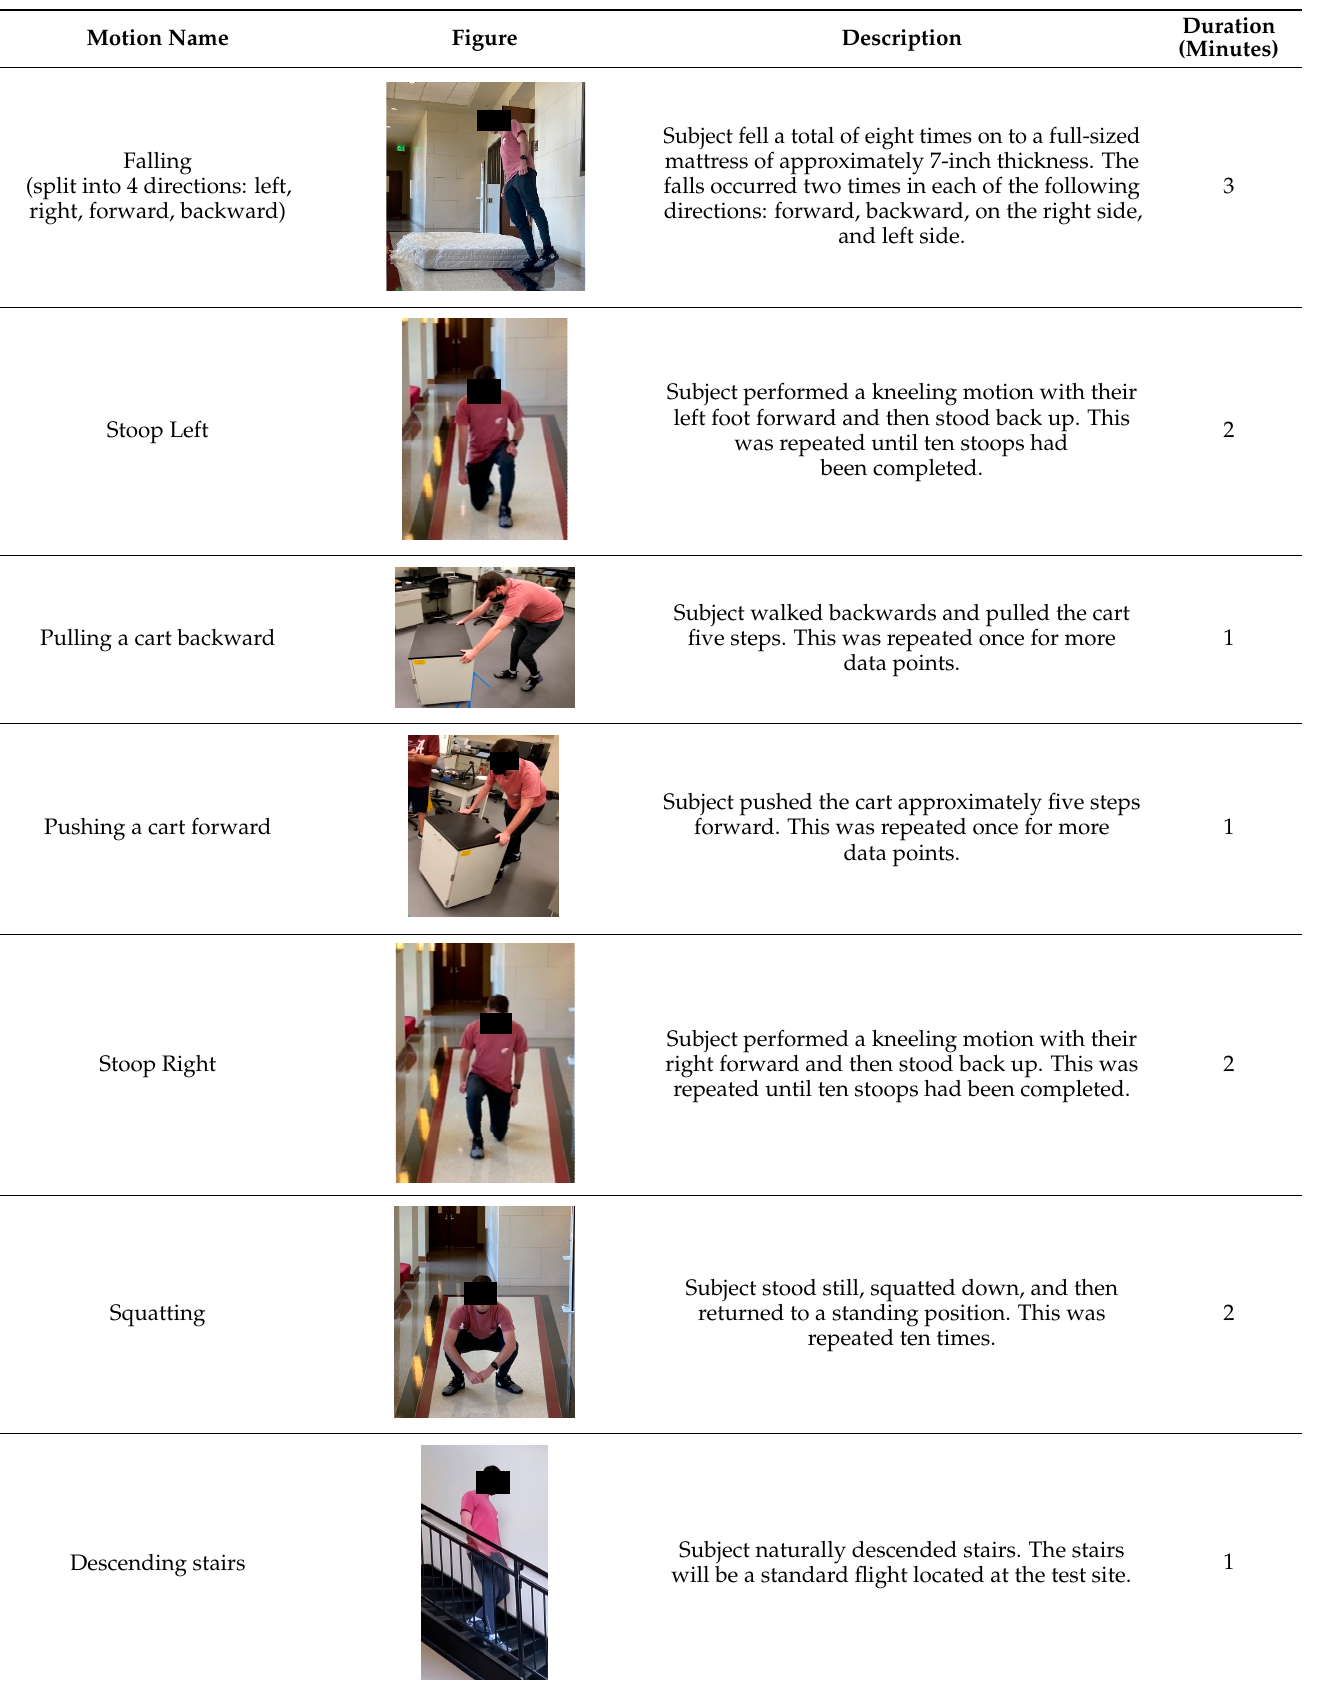
Table 2. Detailed description of all recorded